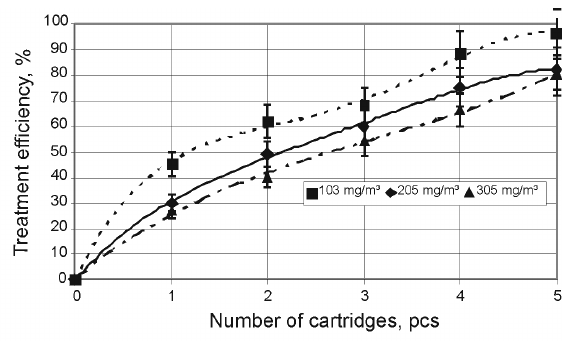
Fig. 5. Dependence of biofilter treatment efficiency on the number of cartridges when the original concentration of acetone is varying